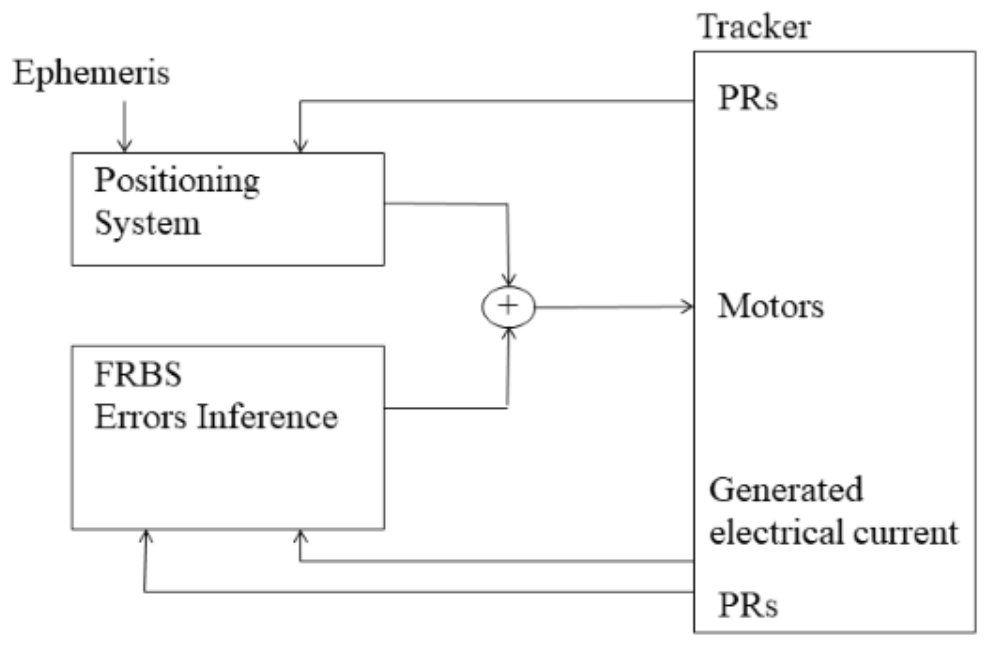
Figure 2. Controller structure.